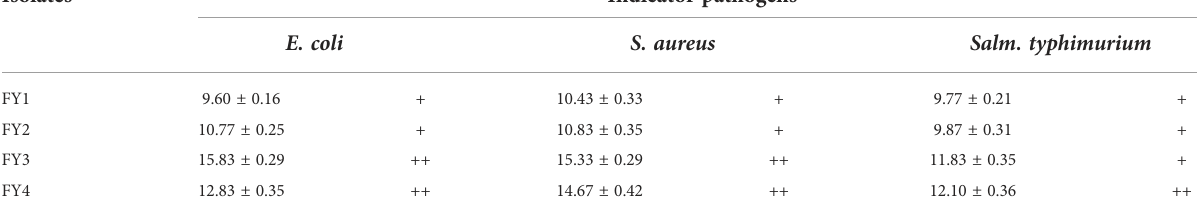
TABLE 2 The inhibition zone diameters (mm) of four strains against E. coli , S. aureus and Salm. typhimurium.